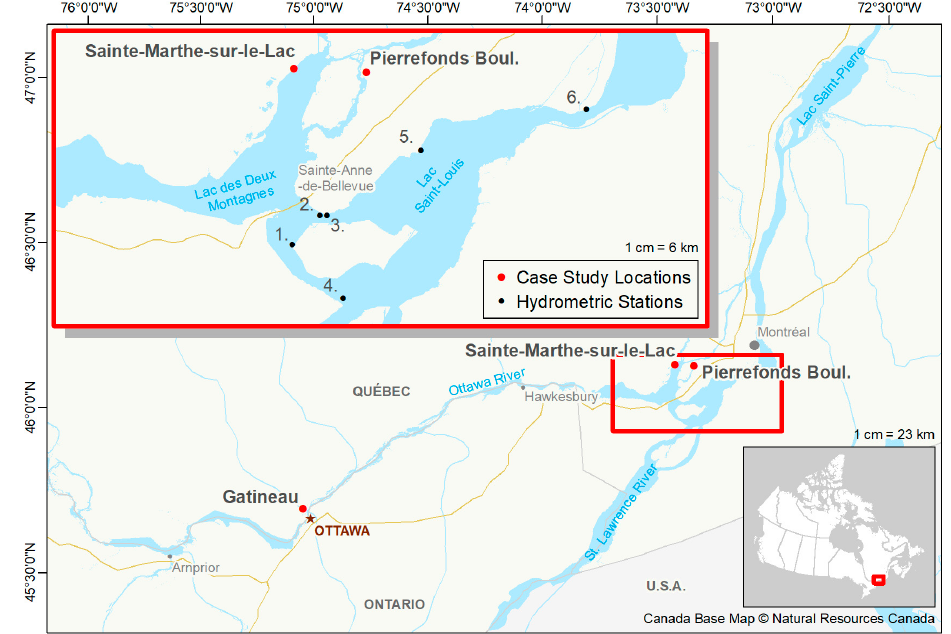
Figure 1. The approximate east-west extent of the region of Central Canada along the Ottawa and St-Lawrence Rivers a ff ected by the 2017 and 2019 flood events, with three urban borough regions of interest used as urban flood mapping case studies shown as red dots. Black dots show hydrometric station locations 1. 02OA107; 2. 02OA013; 3. 02OA033; 4. 02MC005; 5. 02OA039; and 6. 02OA016 referred to in Figure 2.